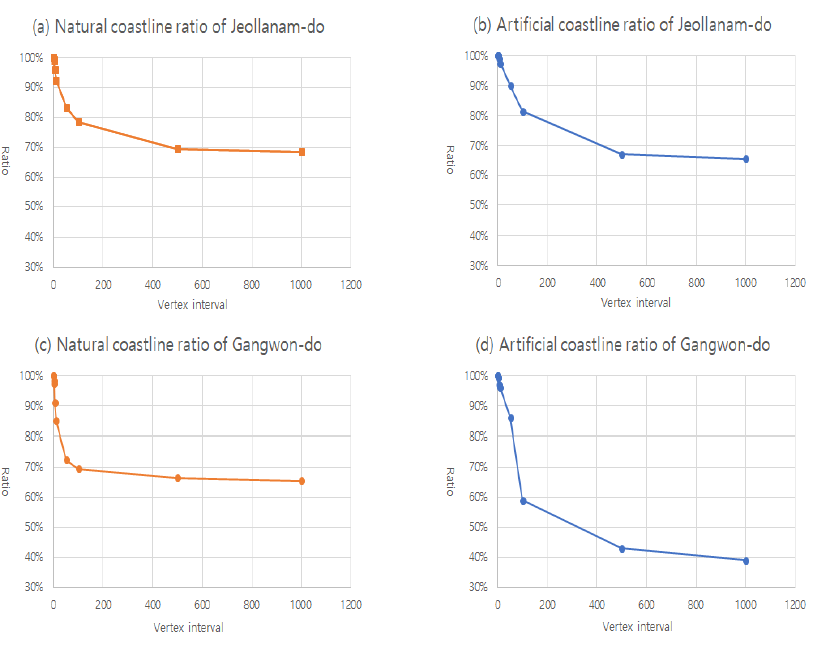
Figure 3. Coastline length change rate according to generalization [0.01m~1000m]